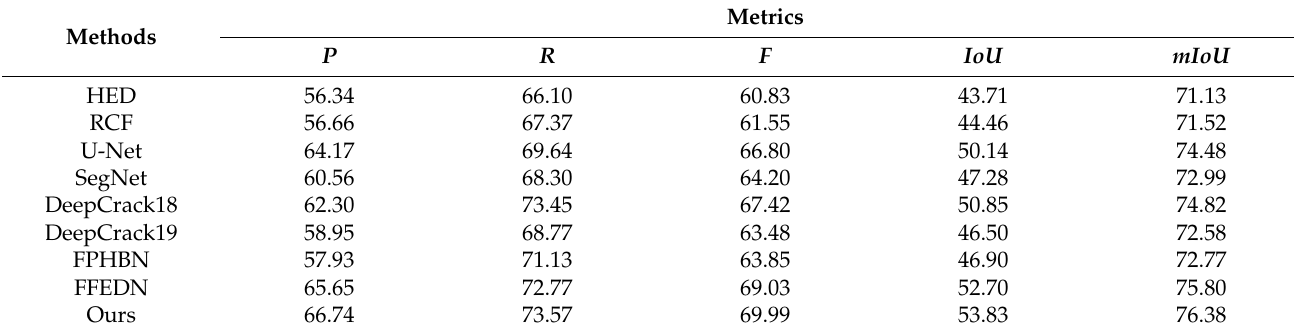
Table 2. Comparison results on